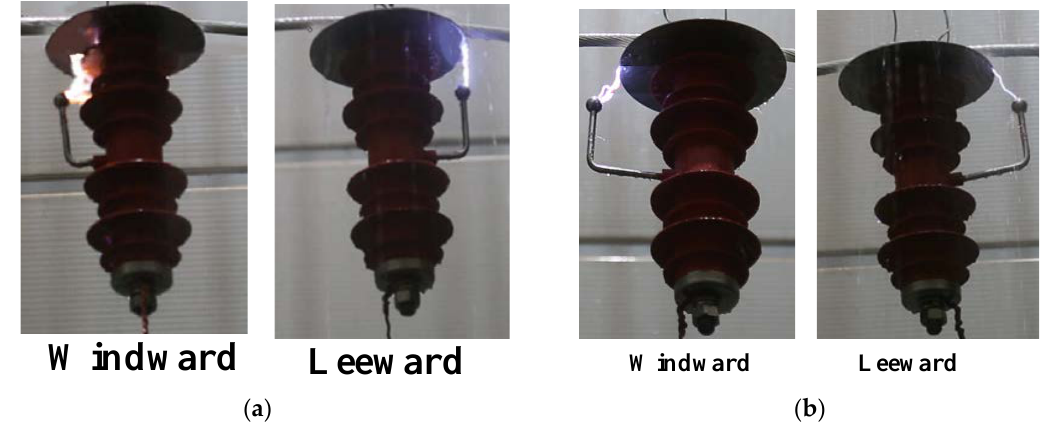
Figure 9. Wind effects on the flashover paths: ( a ) type 1; ( b ) type 2.